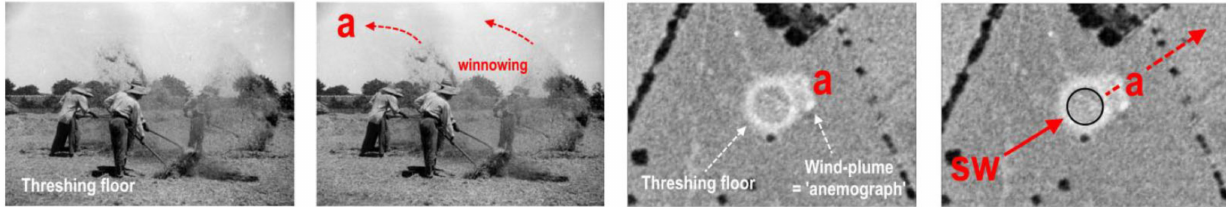
Figure 6. From left to right, methodological procedure to deduce the wind direction around the threshing floor. Point ‘a’ sets out the movement of the dust and straw and its buildup downwind of the threshing floor, forming a ‘wind-plume’. The third image gives the morphological key to know the prevailing wind direction, as a function of the resultant wind-plume, and its corresponding